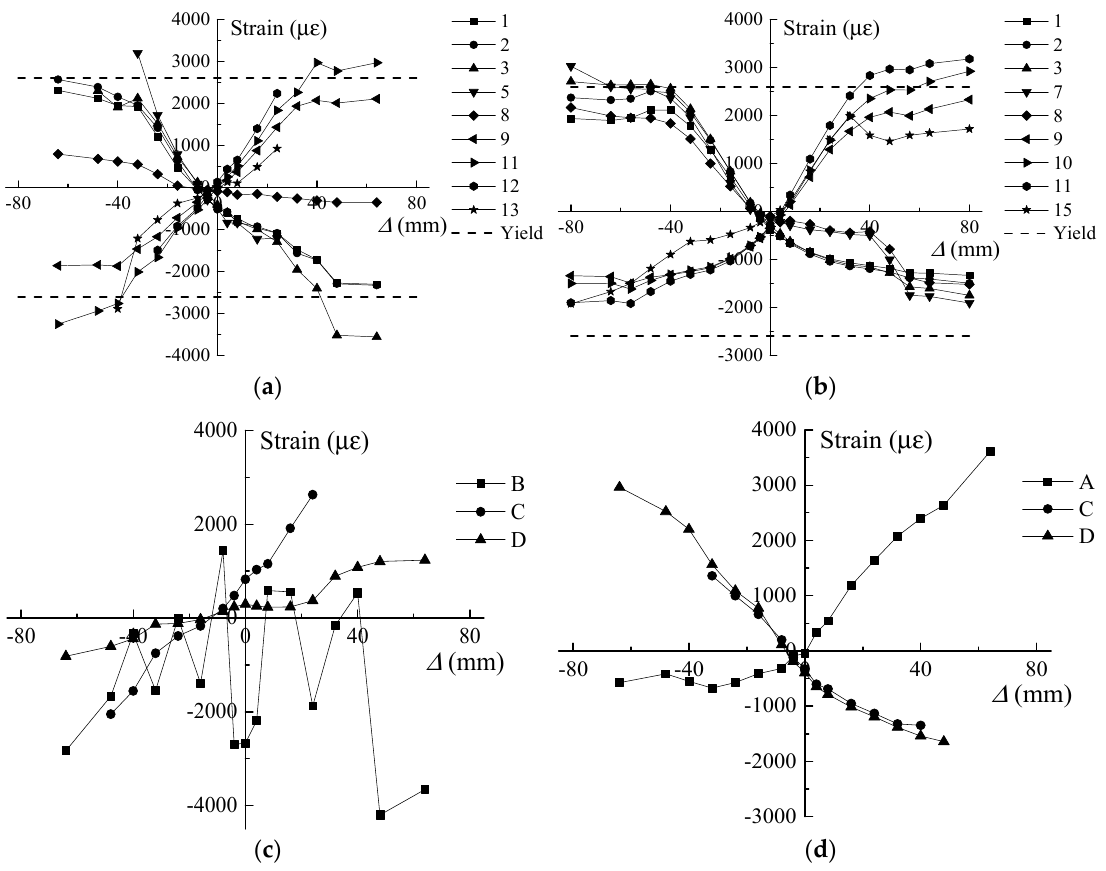
Figure 8. Strain variations of steel and FRP bars with increasing displacement. ( a ) RC, steel bars; ( b ) RC-ECC, steel bars; ( c ) RC, GFRP bars; ( d ) RC-ECC, GFRP bars.